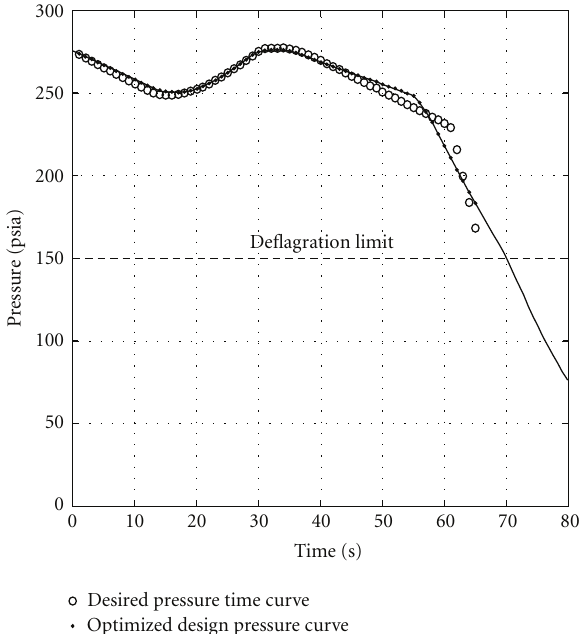
Figure 10: Optimized pressure-time curve for regressive-progres- sive-regressive profile allowing outer-mold line to